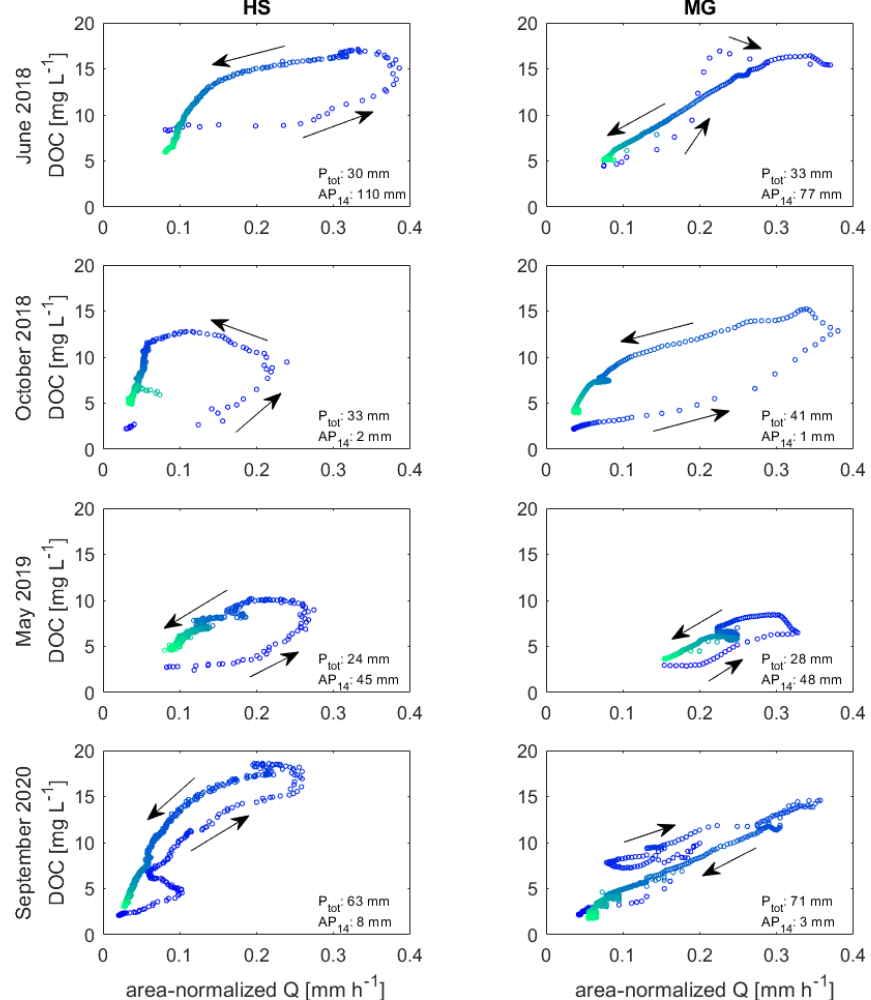
Figure 5. DOC– Q hysteresis during the events in June 2018, October 2018, May 2019 and September 2020 (see gray areas in Fig. 4). The dots represent 15min time steps, starting from dark blue to